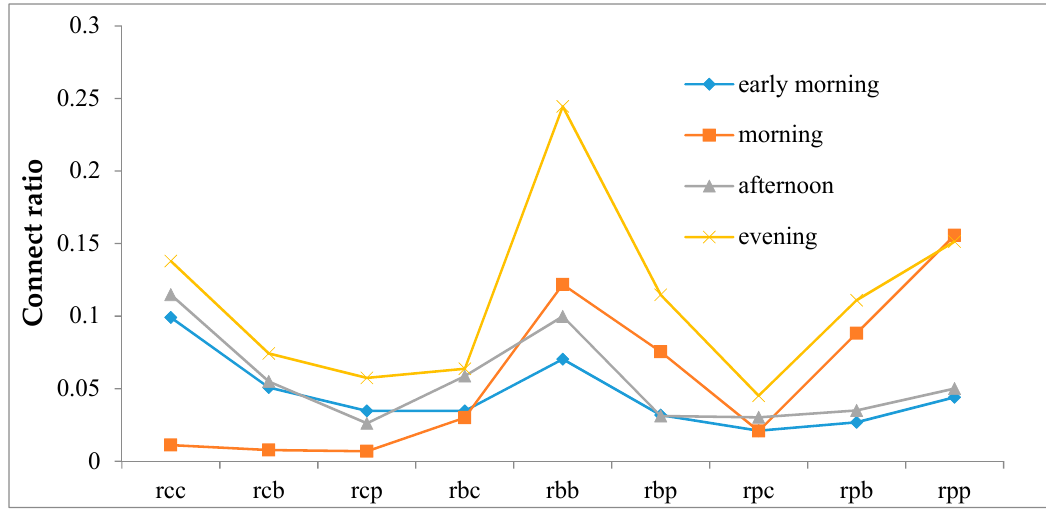
Figure 9. Connection ratio of the core layer, the bridge layer, and the periphery layer on weekends.